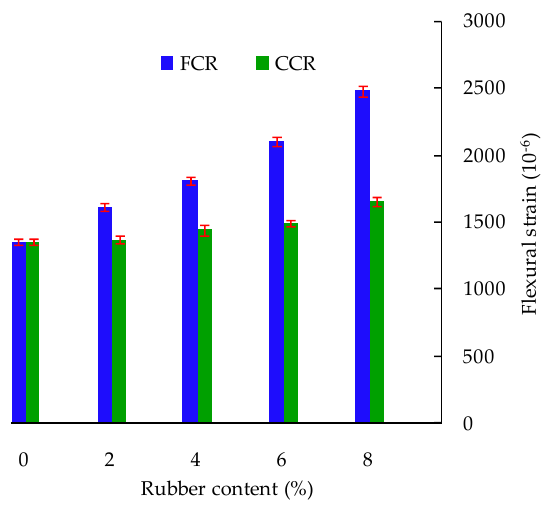
Figure 9. Flexural strain of RMPC versus rubber content.